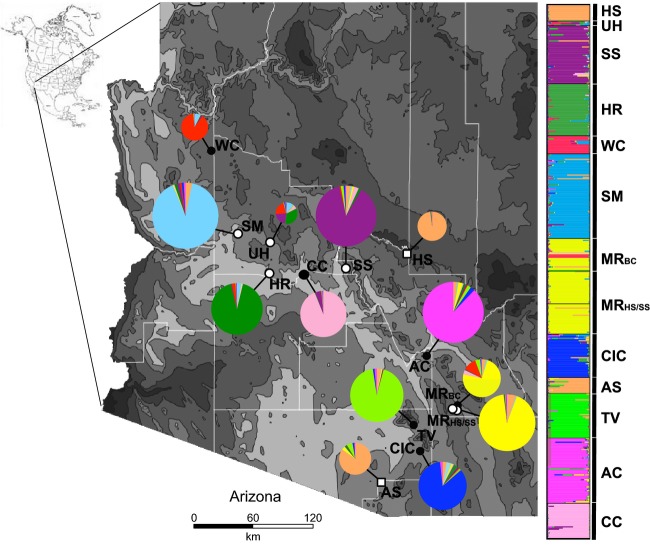
Lithobates yavapaiensis Structure analysis results for K = 10 with individuals grouped by population locality. Left, Map of Arizona showing population localities and proportion of each population sample assigned to the ten genetic demes identified in the Structure analysis. Populations are categorized as susceptible (black circles; populations with observed mortality), tolerant (white circles; no observed mortality), or uninfected (white squares; Batrachochytrium dendrobatidis not detected). Circle size is proportional to the number of genotyped individuals. Right, Proportion of membership to each genetic deme for each of 512 individuals genotyped at 14 microsatellite loci. Population abbreviations follow Fig.1. The 10 genetic demes are represented as follows: AS/HS = purple; MR = light pink; SM = light blue; HR = red; SS = pink; CC = dark green; AC = light green; TV = yellow; CIC = blue; WC = tan.